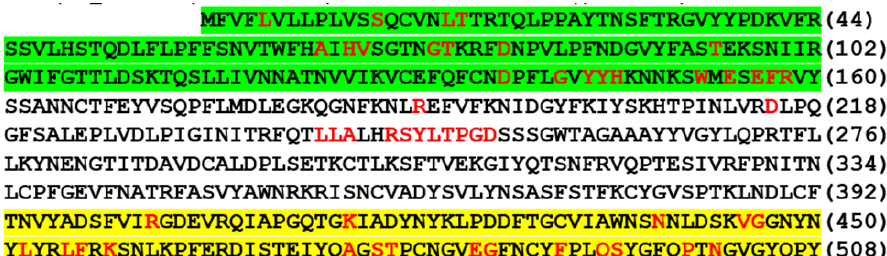
Figure 2. This is a figure showing the first 508 amino acids of SARS-CoV-2 S protein with high-